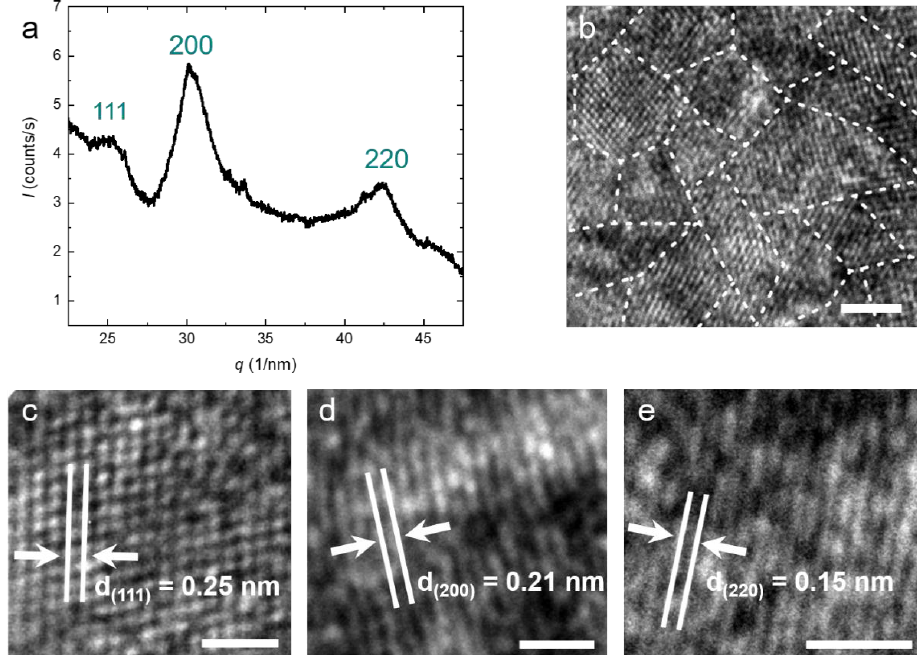
Figure 2. ( a ) XRD spectrum of the purified TiON nanoparticles. The peak position relative to the fundamental q* is obtained as √3:2:√8 , which indicates the face-centered cubic (fcc) crystal structure for the TiON nanoparticles with a lattice parameter a = 0.416 nm; ( b ) HRTEM image of the synthesized TiON nanoparticles. The image shows the crystalline domains; ( c – e ) HRTEM images of the interatomic layer distance. The measured distances correspond to the peaks observed in the XRD spectrum ( a ). The scale bars represent ( b ) = 5 nm, ( c – e ) = 1 nm.